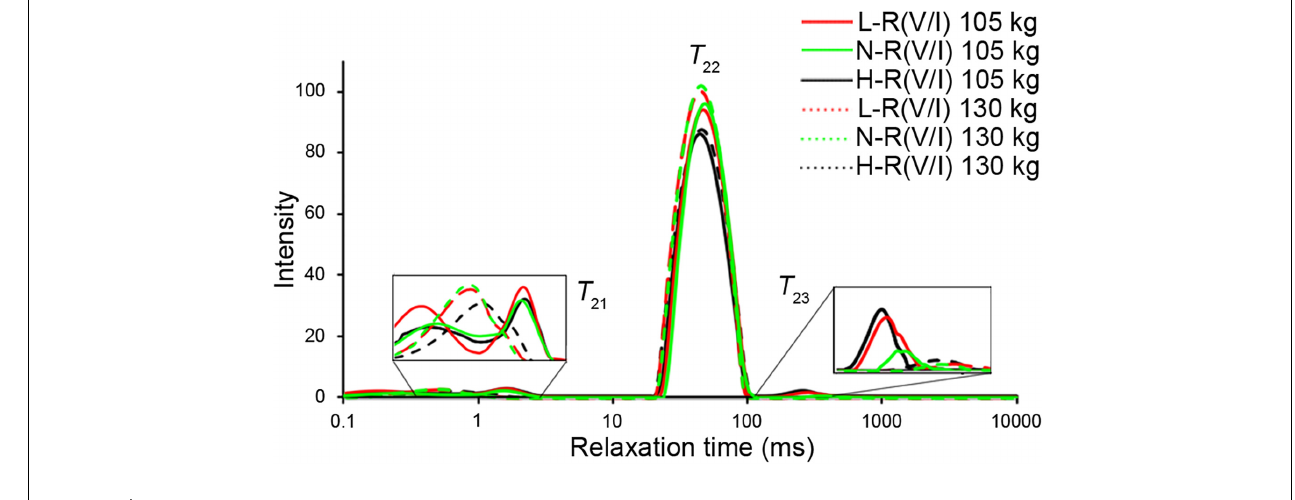
FIGURE 1 | Relaxometry time of LF-NMR ( n = 6).